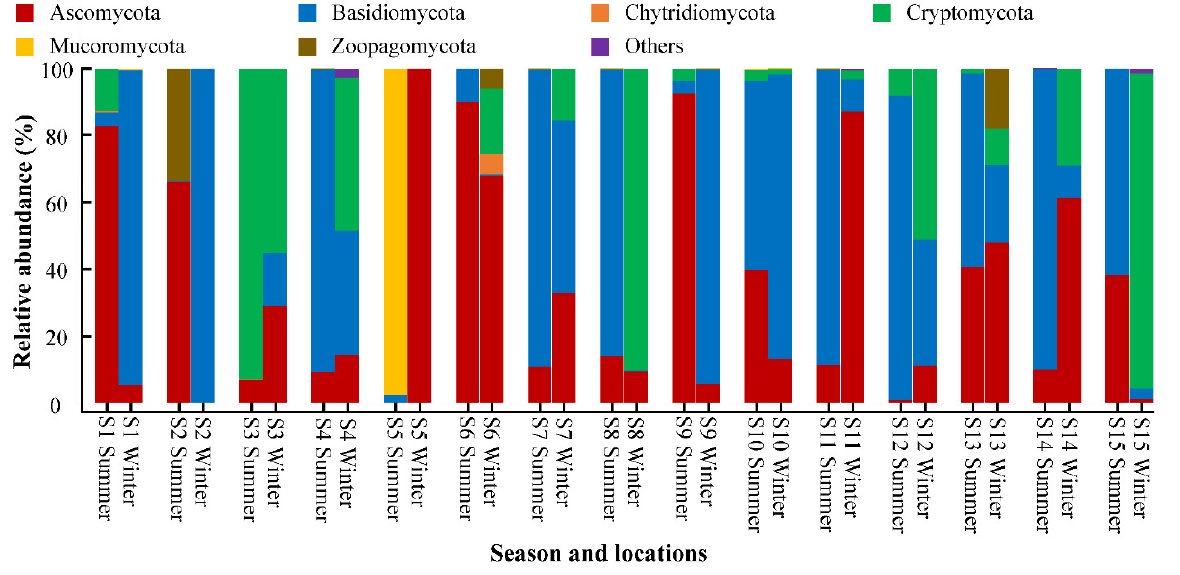
Figure 3. Relative abundance of mycoplankton in summer and winter in the Dafengjiang River estuary (phylum level).